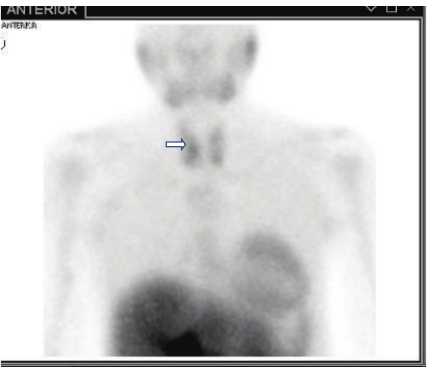
Figure 7: Radionuclide parathyroid imaging using technetium Tc- 99m sestamibi showingslow washout in the right lower thyroid region (denoted by arrow).